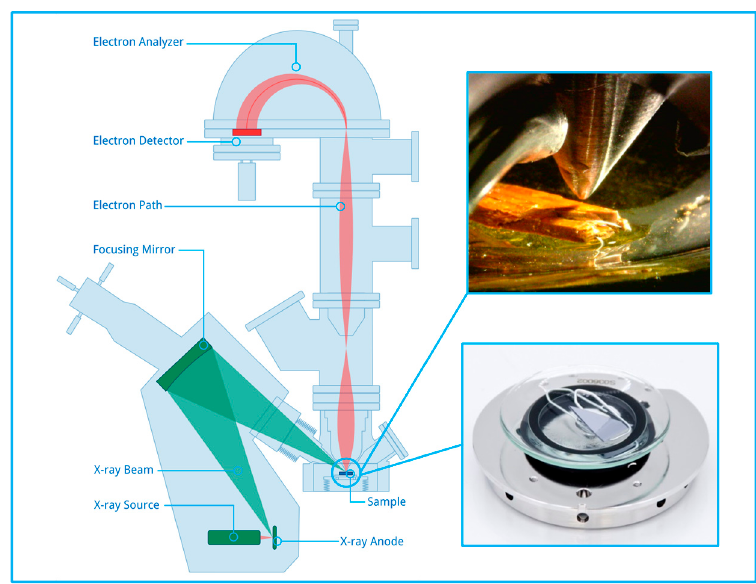
Figure 1. Experimental setup of laboratory Near Ambient Pressure (NAP)–X-ray Photoelectron Spectroscopy (XPS) (EnviroESCA) and an electrolyte (LP30) cathode (V 2 O 5 ) interface in measurement position directly under the analyzer aperture. Additionally shown is a typical solid sample in a liquid using a watch glass, which is placed on a standard sample holder.